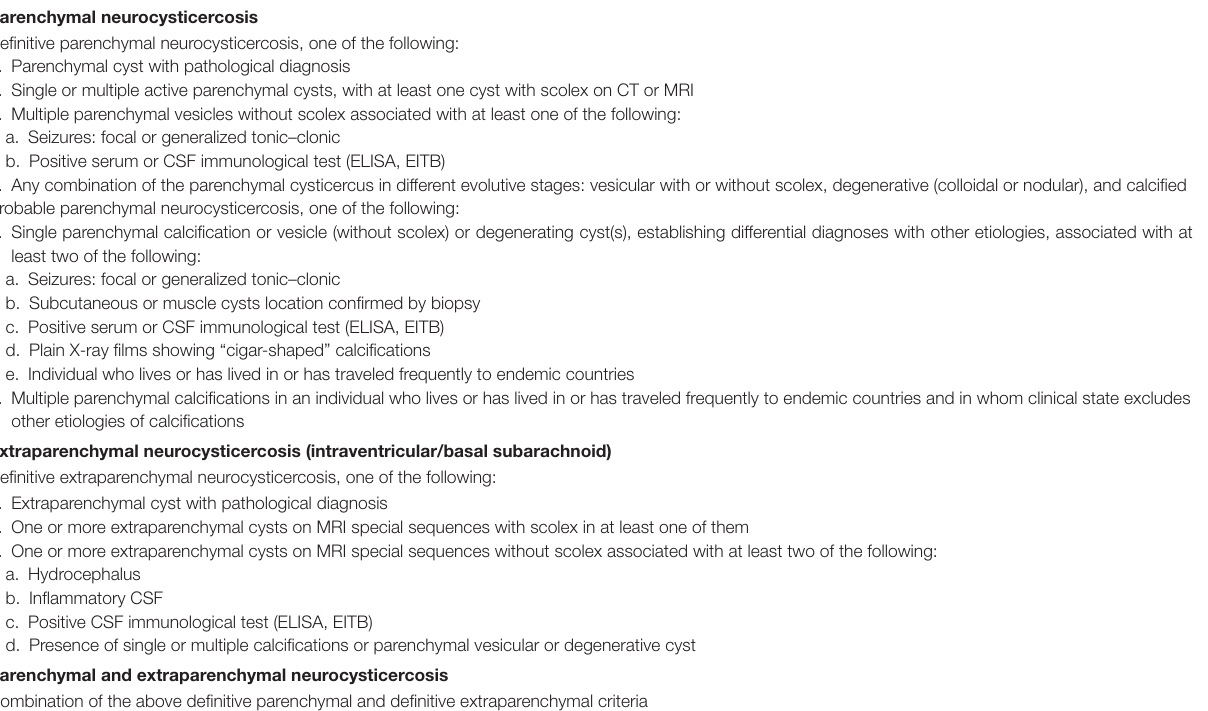
TABLE 2 | Definitive diagnostic criteria for symptomatic neurocysticercosis by Carpio et al. (22). Parenchymal